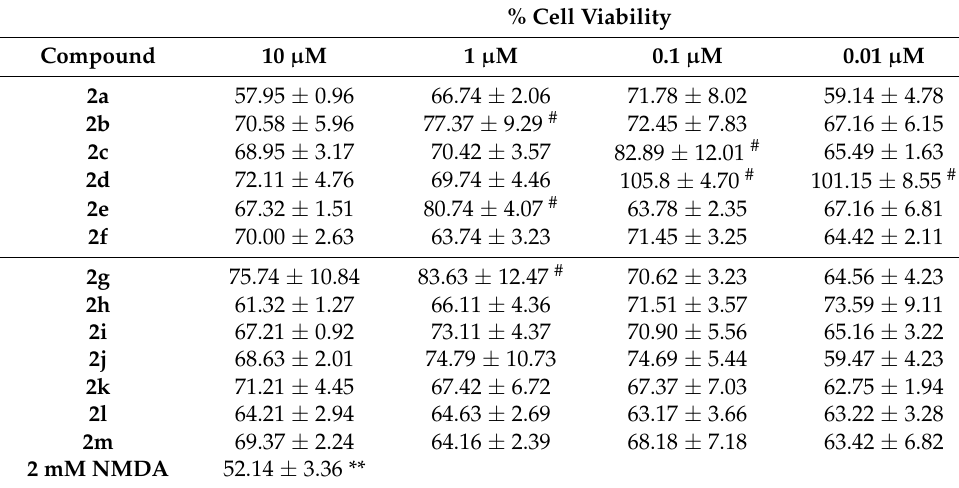
Table 1. Cell viability results following treatment with amino-tomentosin derivatives against NMDAR-mediated excitotoxicity. All values are means ± SDs ( n = 5) and p < 0.05 significant difference from NMDA-treated cells.